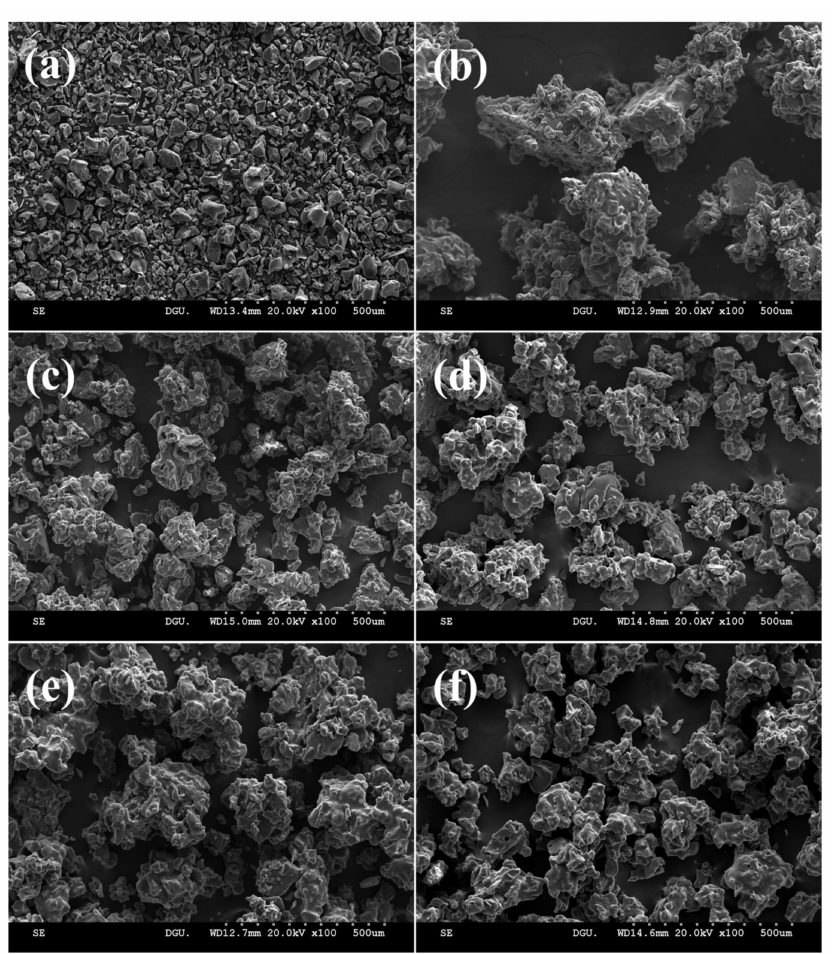
Figure 3. SEM micrographs of raw and agglomerated PPSPs with different concentrations of MD binder: ( a ) raw PPSP, ( b ) PPSP—0%, ( c ) PPSP—10%, ( d ) PPSP—20%, ( e ) PPSP—30%, and ( f ) PPSP— 40%. Magnification (100 ×